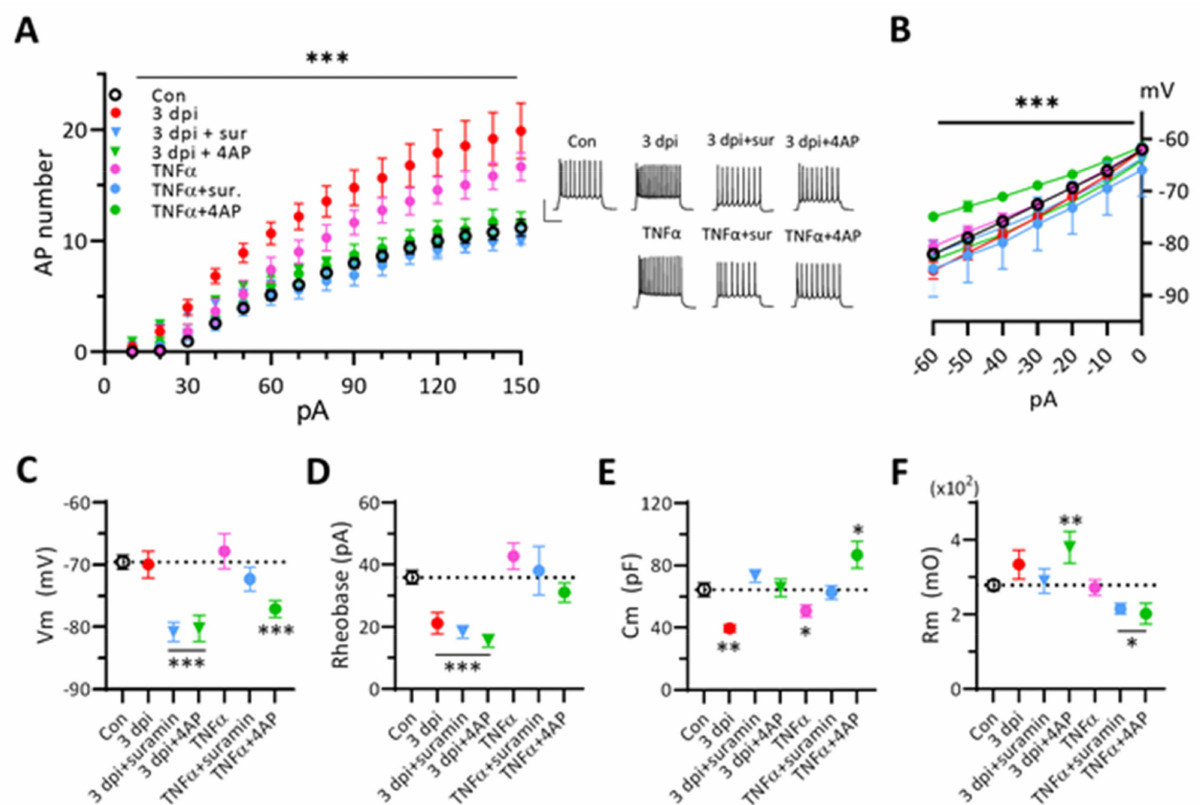
Figure 7. Effects of P2 receptor blocker or K + channel blocker on TNF- α induced excitability changes of naïve neurons compared to ATP-injection induced excitability changes of 3 dpi neurons. Two-way ANOVA with Tukey’s test or two-tailed t -test for comparing the experimental group to the control group (*, p < 0.05; **, p < 0.001; ***, p < 0.0001). ( A ). Effects of suramin or 4-AP on the number of action potential firings of TNF- α -treated naïve neurons or 3 dpi neurons in response to 500 msec depolarization pulses compared with naïve controls. TNF- α (10 ng/mL), suramin (500 µ M), 4-AP (1 mM). Two-way ANOVA with Tukey’s test. Insets , Example traces of cortical neuron firing to +120 pA current injection under each conditions. Scale bars , 50 mV and 200 ms. The same color and symbol of each condition are used in ( A – F ). ( B ). Effects of suramin or 4-AP on I–V plot to hyperpolarizing current steps of TNF- α -treated naïve neurons or 3 dpi neurons. Two-way ANOVA with Tukey’s test. ( C ). Resting membrane potential measurements. Two-tailed t -test. ( D ). Rheobase measurements. Two-tailed t -test. ( E ). Membrane resistance measurements. Two-tailed t -test. ( F ). Membrane capacitance measurements. Two-tailed t